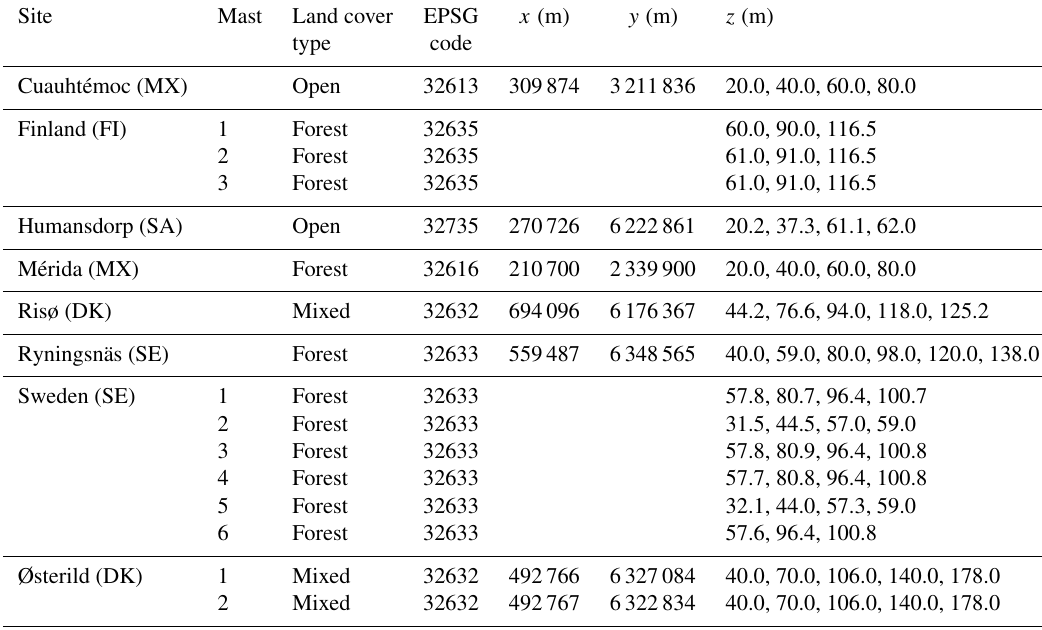
Table 1. Sites and masts used for cross-prediction analyses. The characteristic land cover is indicated. The EPSG code identifies the coordi- nate reference system, including the map projection, datum, and zone number (see text), and the x , y , and z columns identify the positions in projected map coordinates.